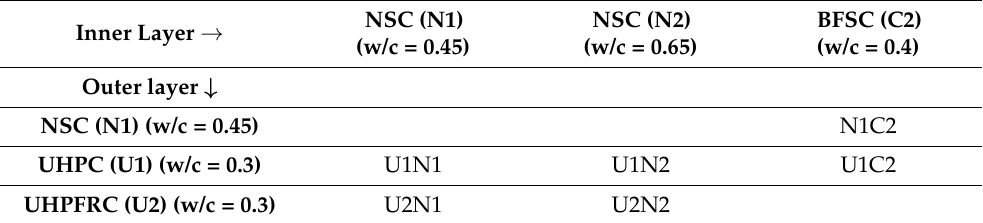
Table 3. Used combinations of